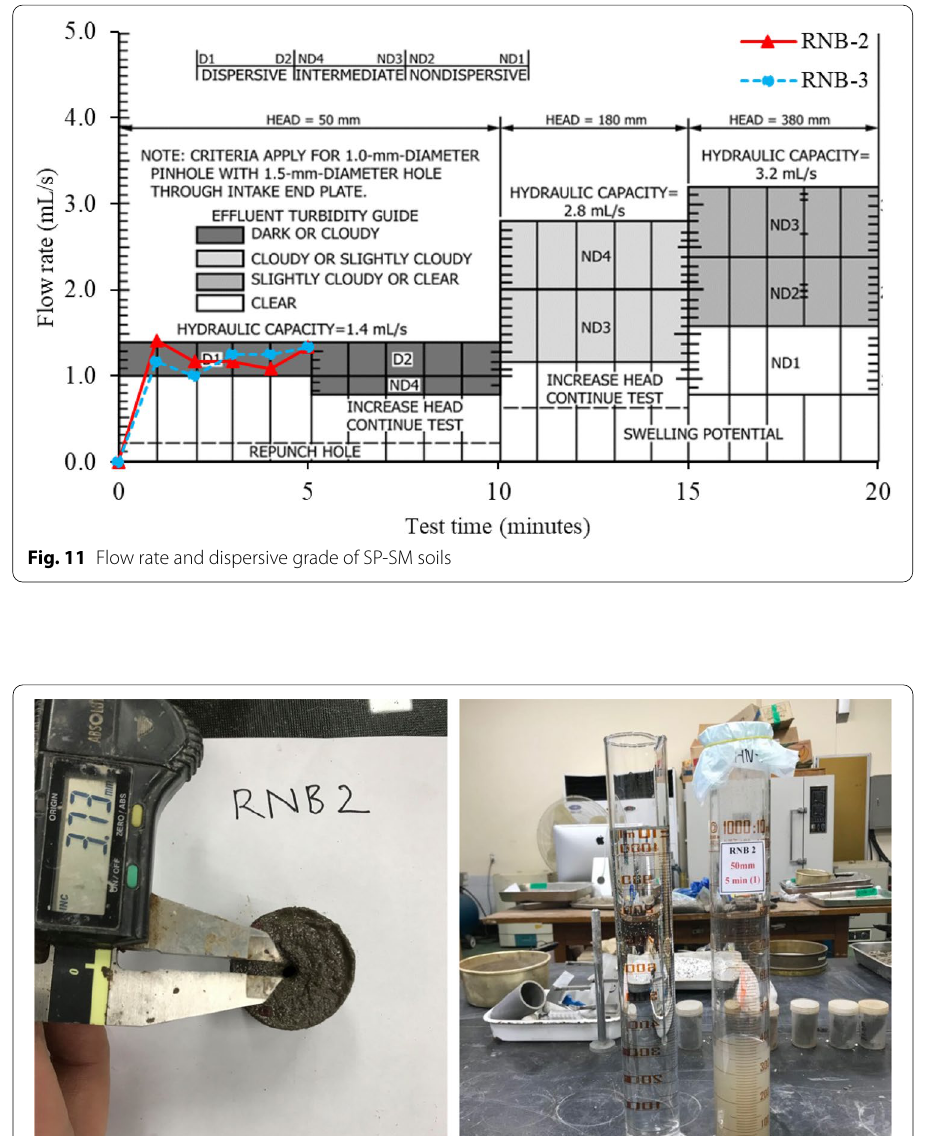
Group 3: SM soil (RNB‑10, RNB‑11, and RNB‑13)